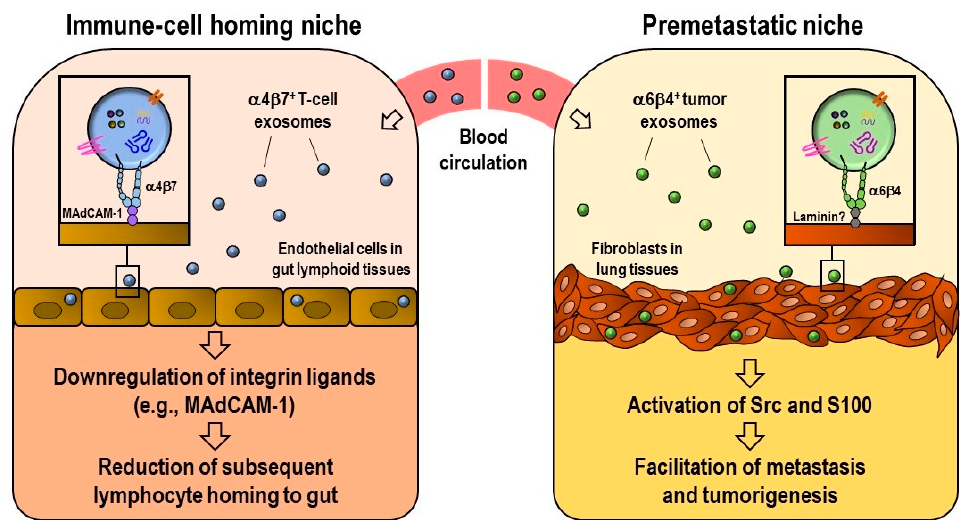
Figure 3. Exosomal integrin ‐ mediated remodeling of the homing niches of immune cells (left) and cancer cells (right).